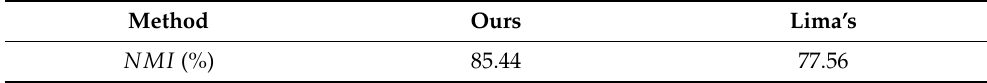
Table 3. NMI of the proposed ReID method and state-of-the-art